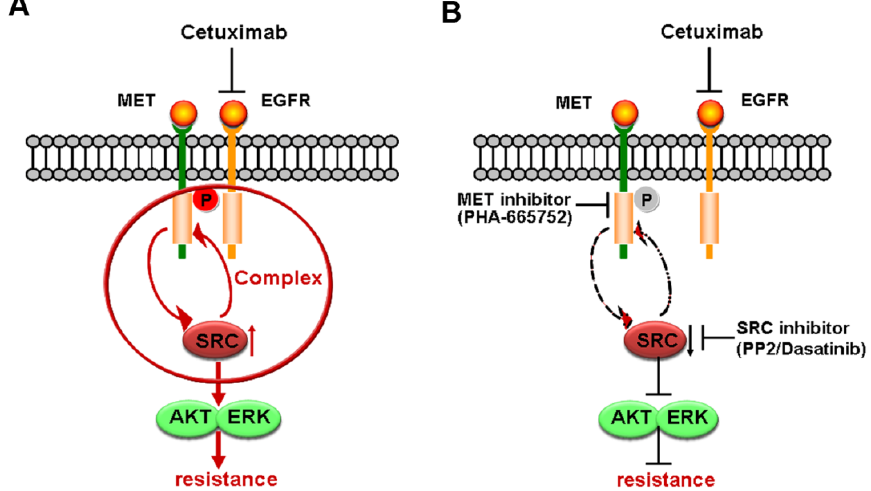
Figure 6. Schematic representation of the proposed model involved in cetuximab-induced MET activation. ( A ) Application of cetuximab promotes MET phosphorylation coupled with SRC activation in Caco-2 cells. The positive feedback between MET and SRC and formation of MET/SRC/EGFR complex heighten cetuximab resistance; ( B ) Inhibition phosphorylation of MET and SRC by inhibitors disrupts the interaction of MET with SRC and formation of MET/SRC/EGFR complex, ultimately reversing cetuximab